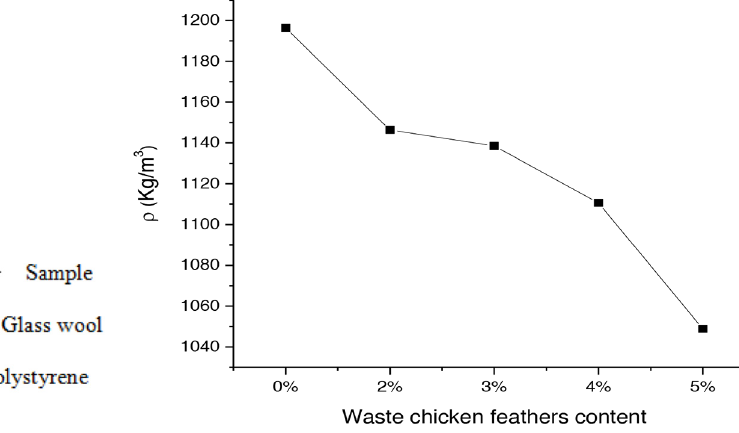
Fig. 4. Apparent density of the